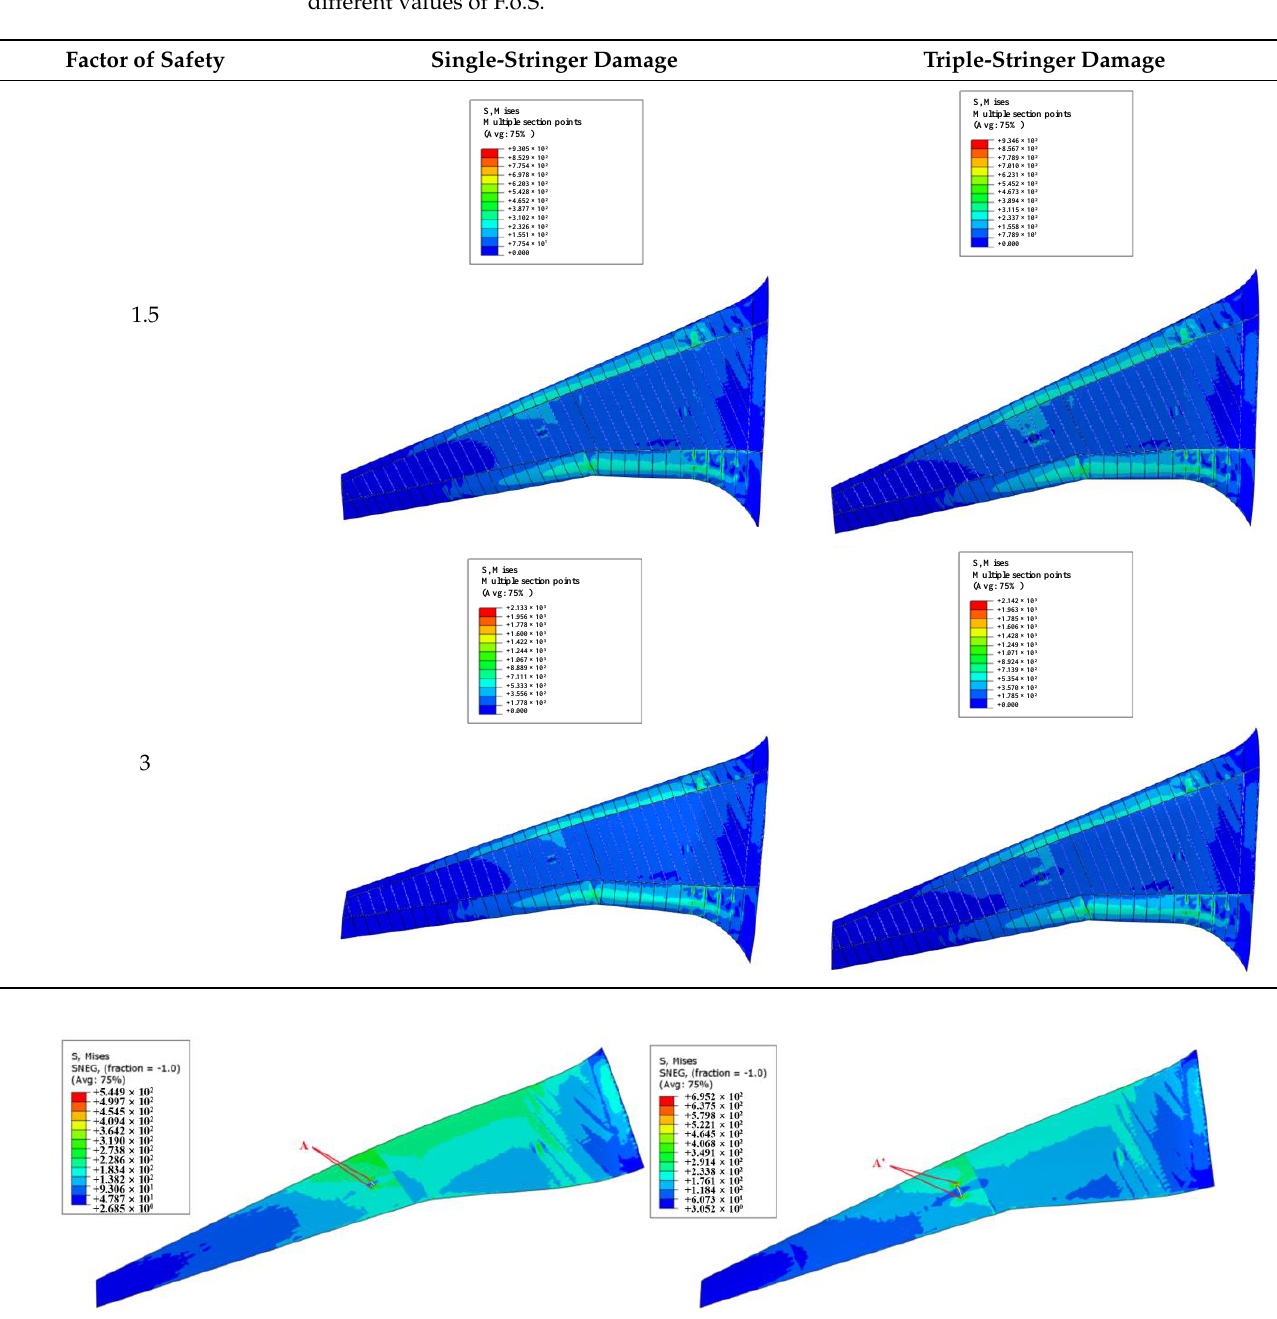
Figure 8. Stress concentration at the tips of the stringer cut in the lower skin component at F.o.S. = 2 (single-stringer damage on the left, triple-stringer damage on the right). Results of the maximum in-plane principal strain of single-stringer and triple- stringer damage BWB wings at different values of F.o.S. are presented in Table 7. The maximum in-plane strain in the wing assembly was found to occur at the point of contact